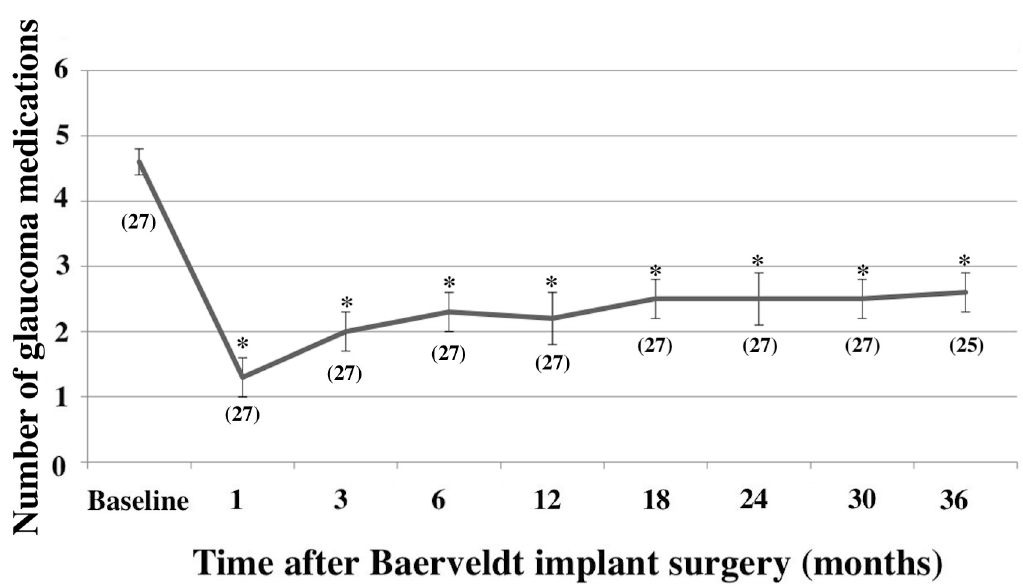
Fig 3. Postoperative transition of the number of glaucoma medications. The mean numbers of glaucoma medications ± standard error of the means (SEM) during the preoperative and 1-, 3-, 6-, 12-, 18-, 24-, 30-, and 36-month after Baerveldt implant surgery are shown. � P < 0.001, compared with the preoperative mean number of glaucoma medications based on the analysis of variance with Bonferroni correction. The number of eyes at each time point is shown in parentheses.